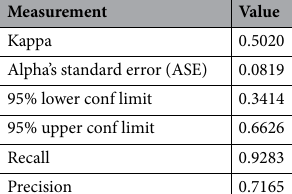
Table 11. Normalized and cumulative importance’s for each of the features with normalized importance greater than zero. a,b The importance’s were calculated using boosting ensemble tree-based machine learning as a factor of how much they contributed to the correct binary classification where the labels were ‘No to moderate lameness’ for assigned mobility scores of 0–2 and ‘Severely lame’ for an assigned mobility score of 3.